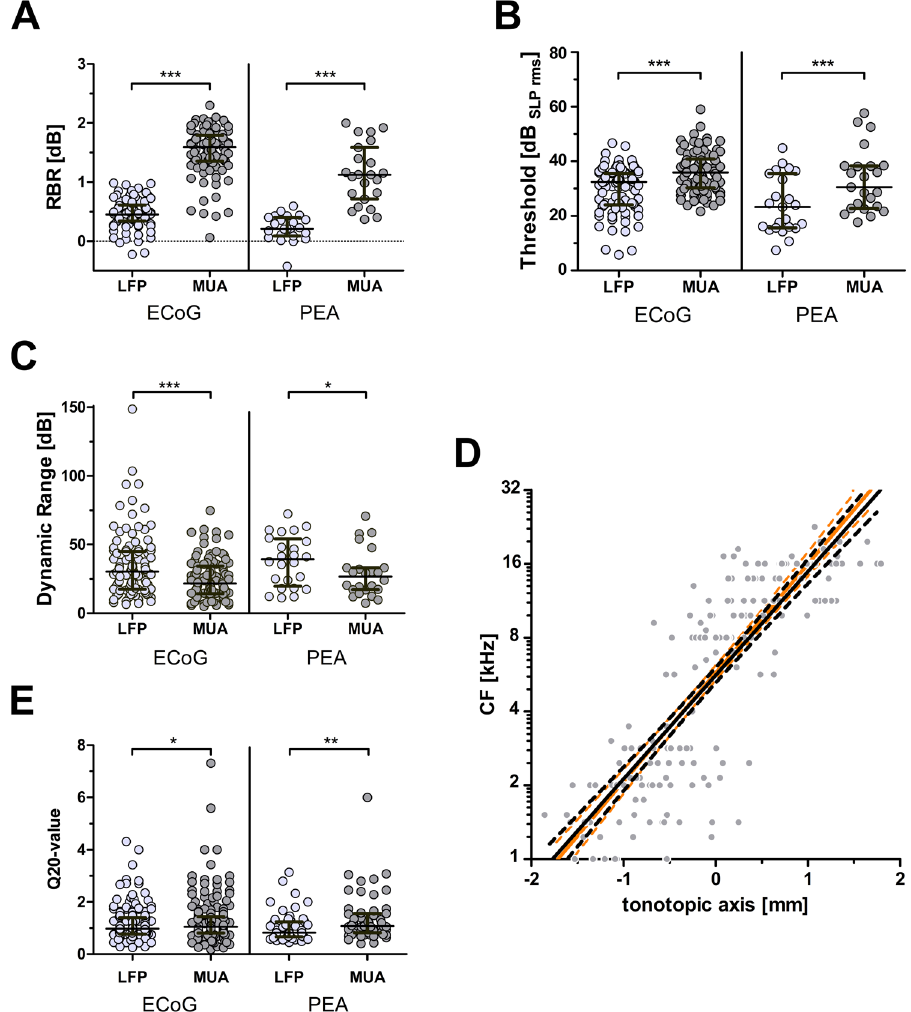
Figure 6. The characterization of the surface responses differed significantly between MUA and LFP measures at the same contacts. ( A ) The response-background ratio (RBR) 20 dB above response threshold was significantly higher (i.e. better) for MUA (based on rate) as compared to LFP (based on amplitude). Given are individual data (dots) and medians with IQR (lines). Wilcoxon test: *** p < 0.0001. ( B ) The response threshold was significantly higher (i.e. worse) for MUA as compared to LFP measures. Given are individual data (dots) and medians with IQR (lines). Wilcoxon test: *** p < 0.0001. ( C ) The dynamic range was significantly lower for MUA as compared to LFP measures. Given are individual data (dots) and medians with IQR (lines). Wilcoxon test: * p < 0.05, *** p < 0.0001. ( D ) The MUA Q20-values were significantly larger (i.e. sharper tuning) compared to LFP Q20-values. Given are individual data (dots) and median with IQR (lines). Wilcoxon test: * p < 0.05, *** p < 0.0001. ( E ) The tonotopy derived by MUA measures (black) at the ECoG grid was similar to the one derived by LFP measures (light orange). Given are individual data (dots) and the linear regression with the 95% confidence interval (solid and dashed